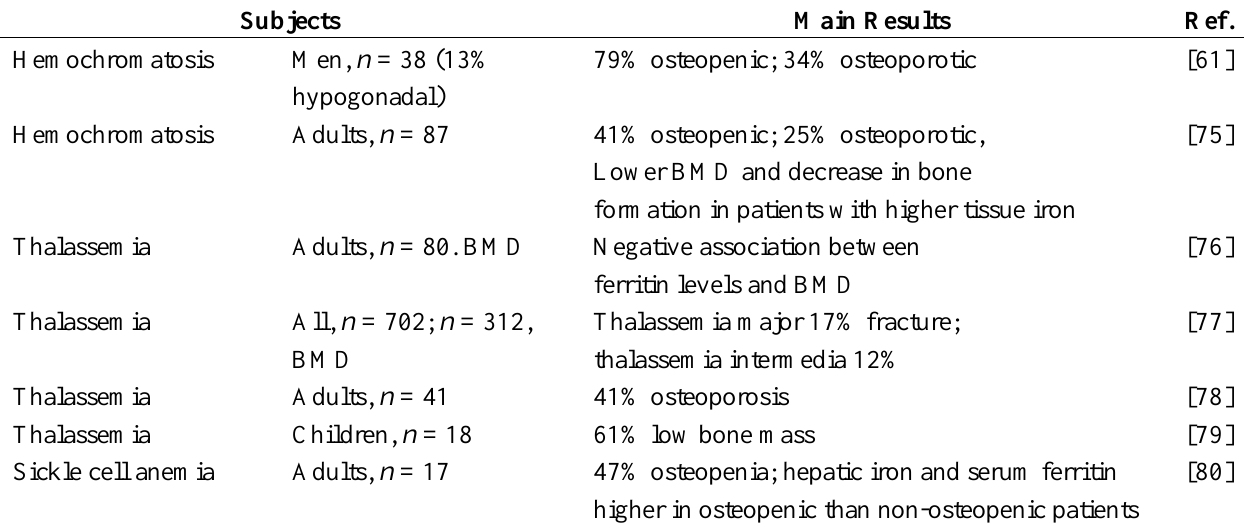
Table 3. Effects of iron overload on bone health in